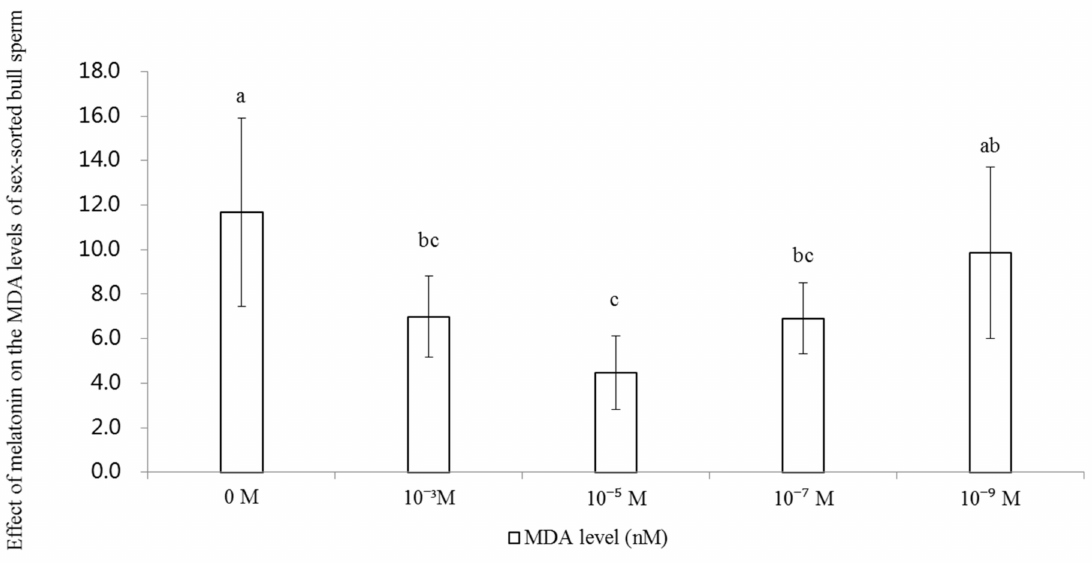
Figure 4. E ff ect of melatonin on the level of MDA of sex-sorted bull sperm. Lowercase letters represent statistical significant di ff erence ( p <